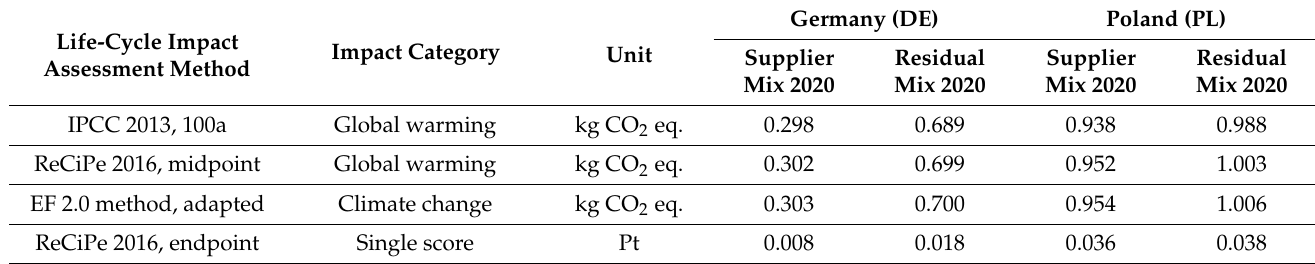
Table 3. Environmental impact of the production of 1 kWh of electricity, calculated for residual and supplier mixes modelled in accordance with data presented in Table